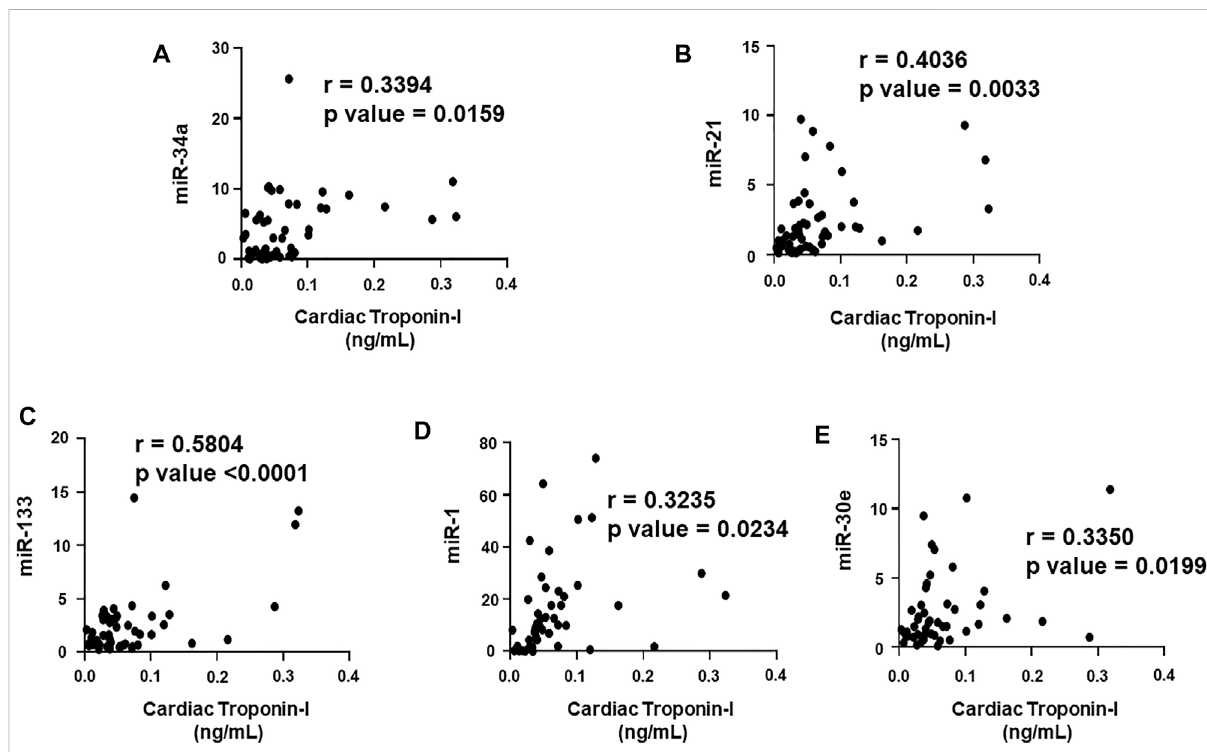
FIGURE 4 Correlation analysis of cardiac troponin I with circulating plasma miRNAs. Correlation analysis was performed using a scatter plot between cardiac troponin I and plasma miRNAs, (A) miR-34a, (B) miR-21, (C) miR-133, (D) miR-1, (E) miR-30e. Pearson ’ s r coef fi cient was used to determine the extent of correlation and statistical signi fi cance was obtained by two-tailed p -value. Each plot independently demonstrates the correlation (Pearson ’ s r coef fi cient) and signi fi cance ( p —